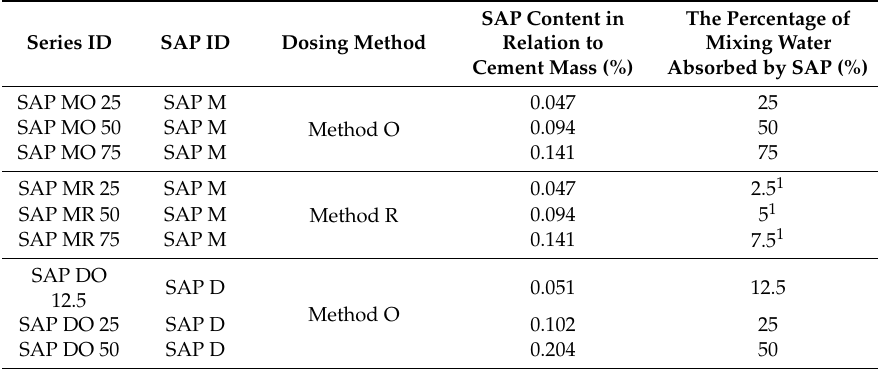
Table 5. List of prepared superabsorbent polymers (SAP)-modified concrete mixes. Each of the mixes characterized by the same total water-cement ratio (w/c) tot =